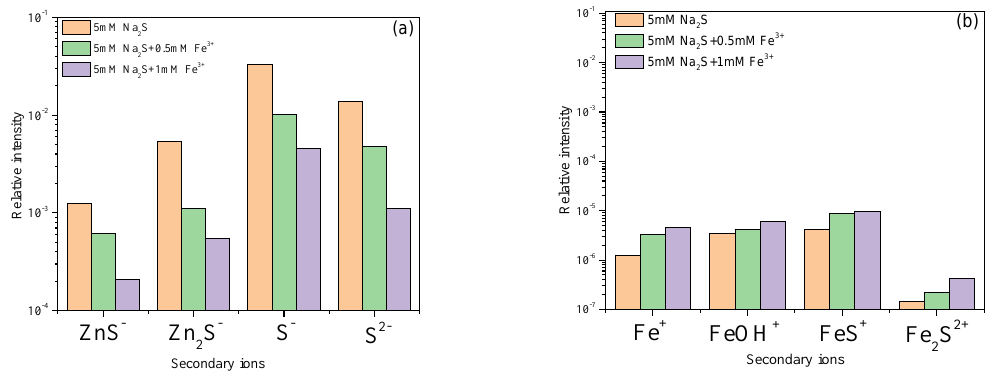
Figure 5. Relative intensities of ( a ) positive secondary ions and ( b ) negative secondary ions on the hemimorphite surface layer.